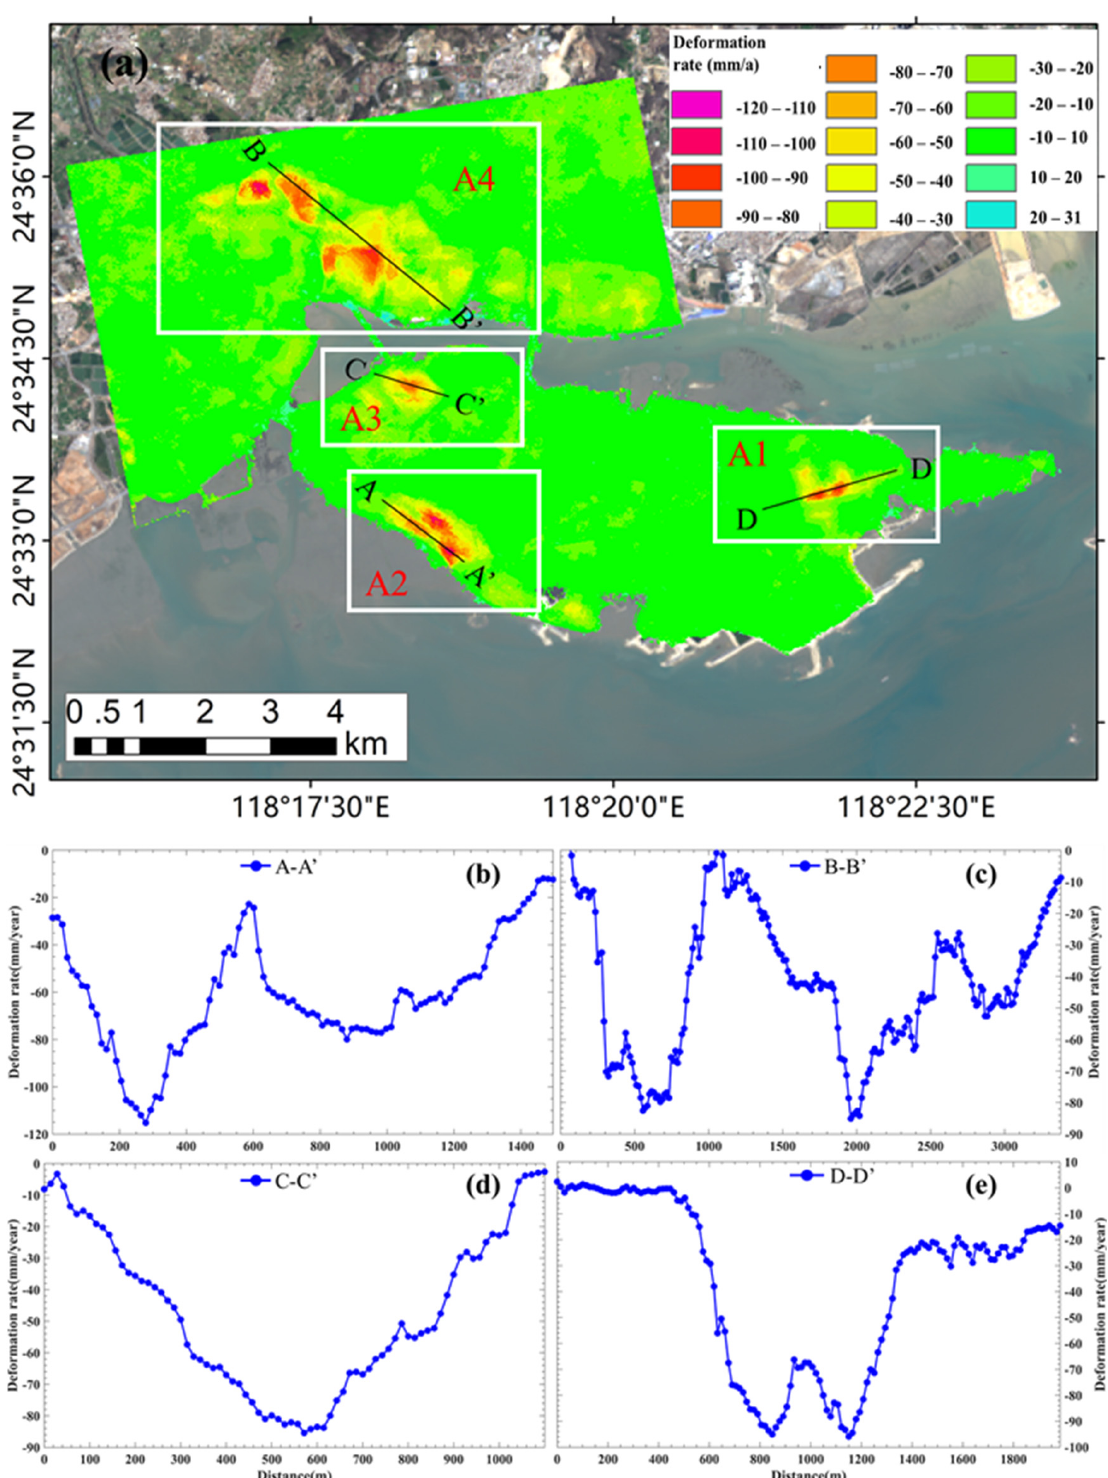
Figure 5. ( a ) Annual vertical deformation rate map of Dadeng Island. Cross-sections of the annual vertical deformation rate of Shuangyu Island along four profiles, whose positions are marked in Figure 5a, ( b ) Profile A–A’; ( c ) profile B–B’; ( d ) profile C–C’; ( e ) profile D–D’.